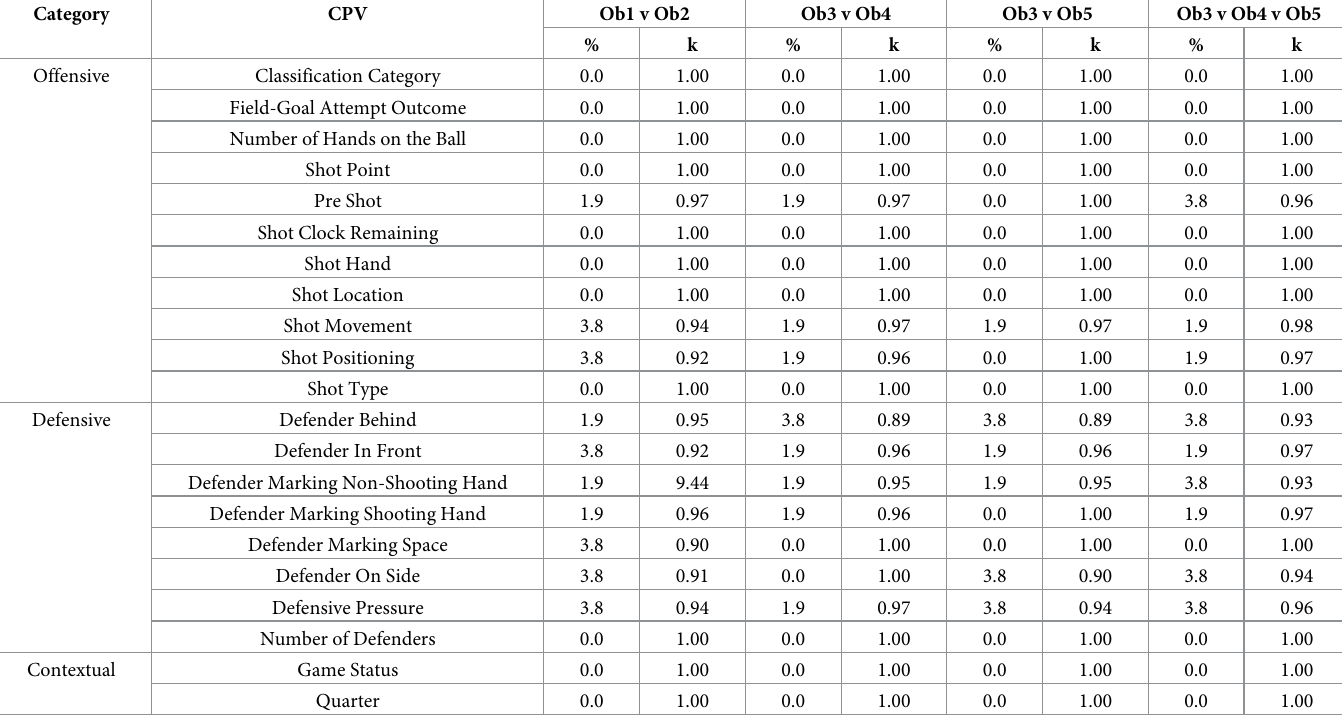
Table 2. Intra-observer and inter-observer reliability test results for the field-goal attempt template. Category Offensive